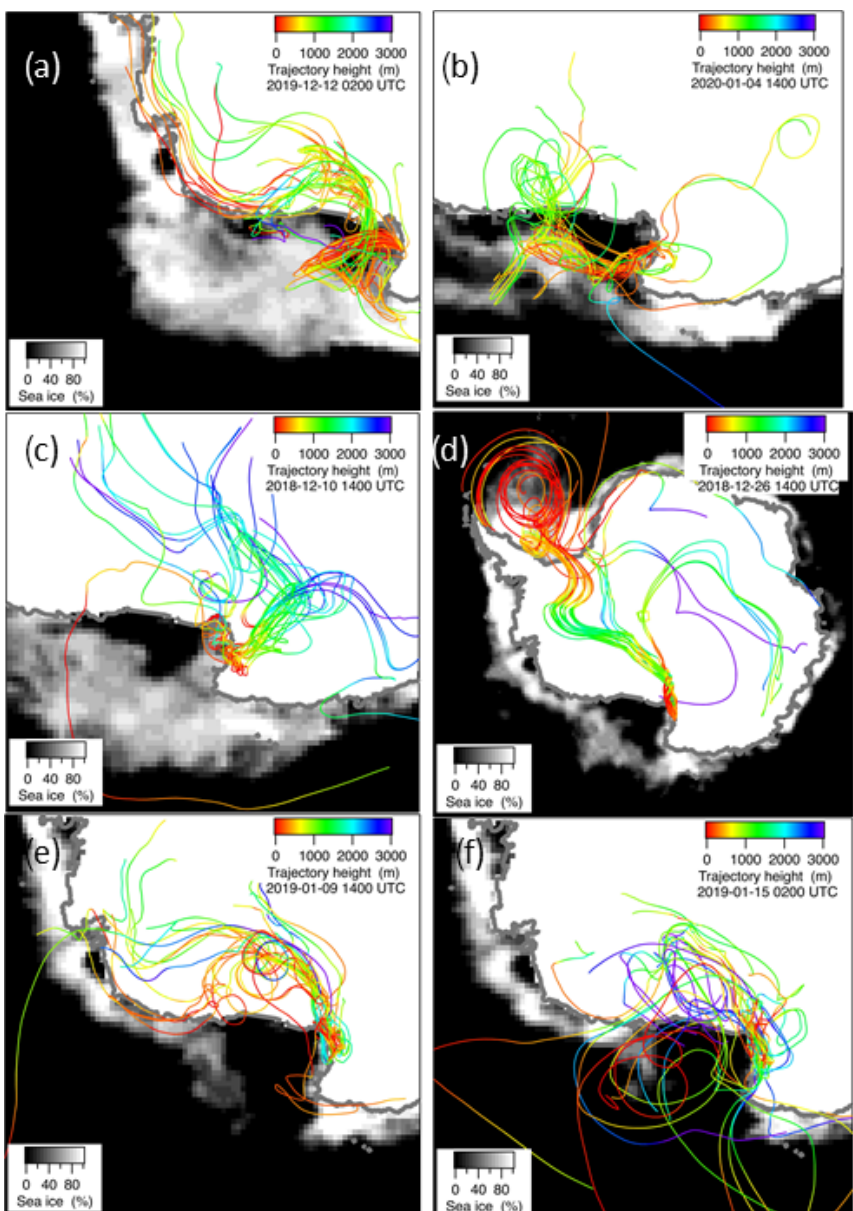
Figure 7. Ensemble of 10-day backward trajectories at 300ma.g.l. (above ground level) arrival height for the days 16 December 2019 (a) , for these days. Trajectory height along the route and sea ice percentage are presented as color or gray scales,